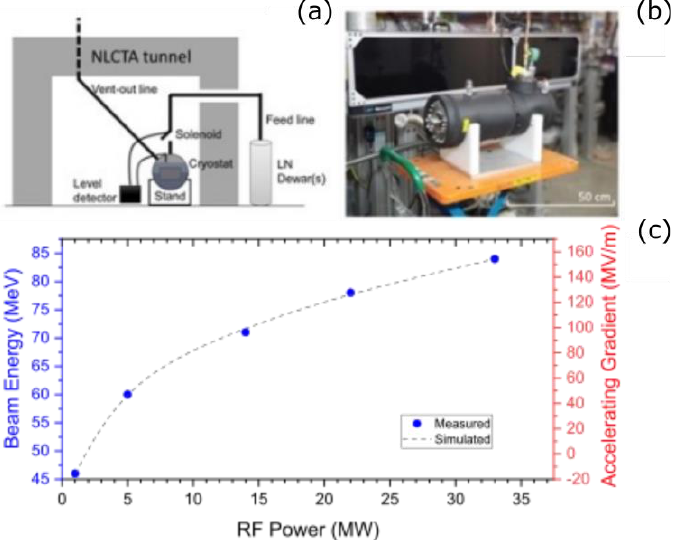
Figure 16. ( a ) Schematic of cryogenic test setup at XTA using liquid nitrogen. ( b ) Photo of linac and cryostat assembly prior to installation at XTA. ( c ) Measurements of accelerating gradient as a function of RF power.